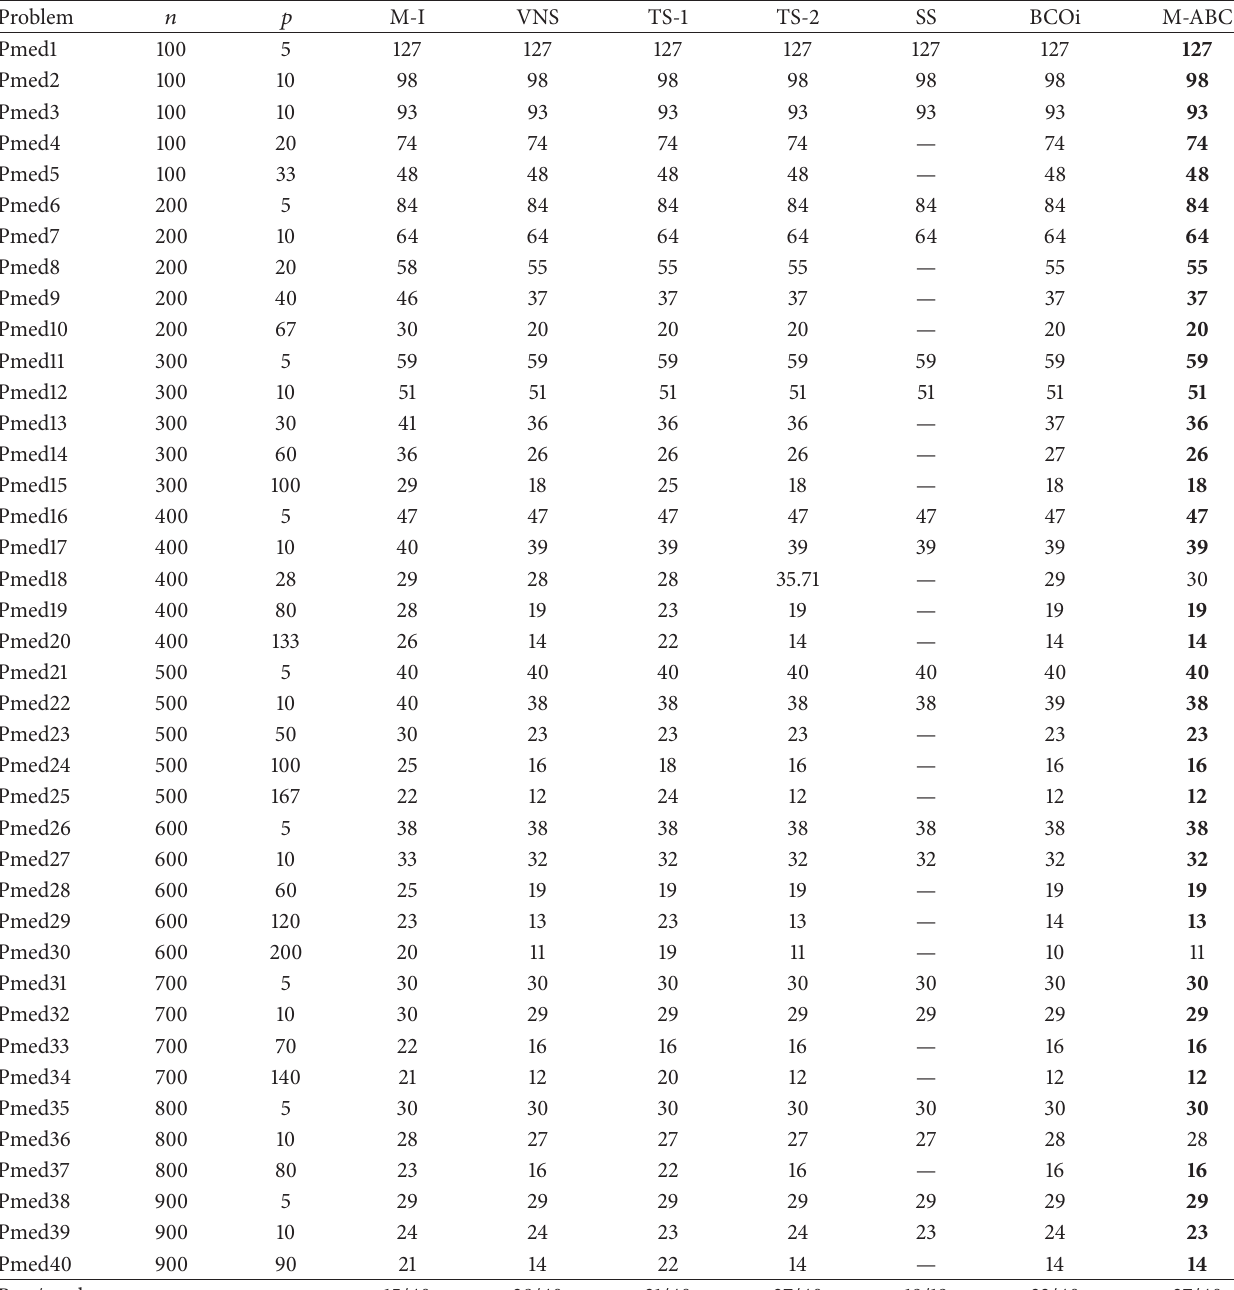
Pseudocode 1: Pseudocode of M-ABC. Table 1: Computational results for benchmark